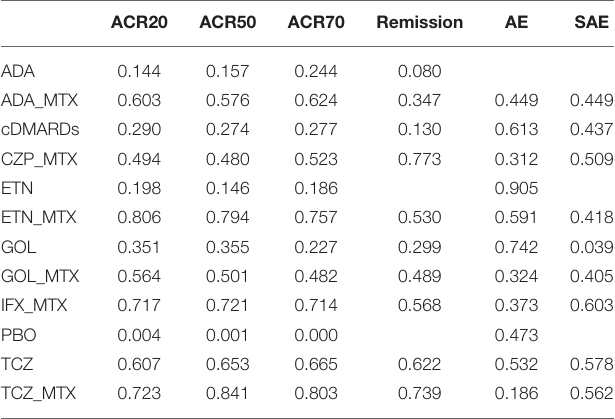
TABLE 4 | The SUCRA value of different treatments on each outcome.